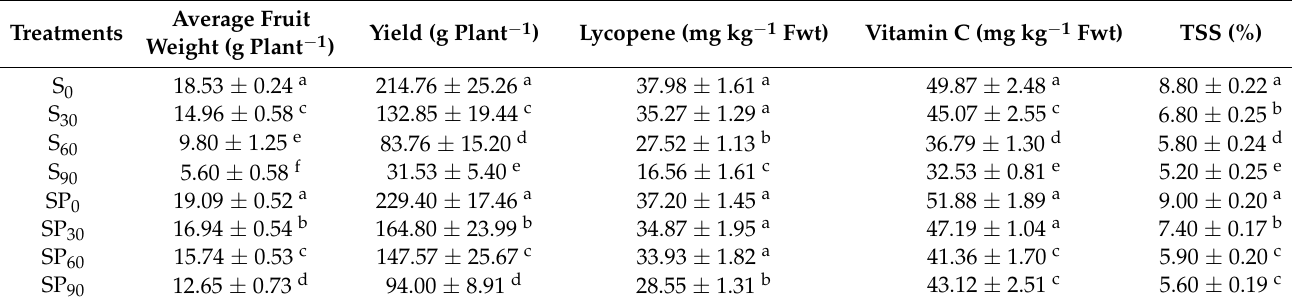
Table 2. Yield and some fruit properties of strawberry plants grown alone or in combination with P. oleracea at differing NaCl levels.